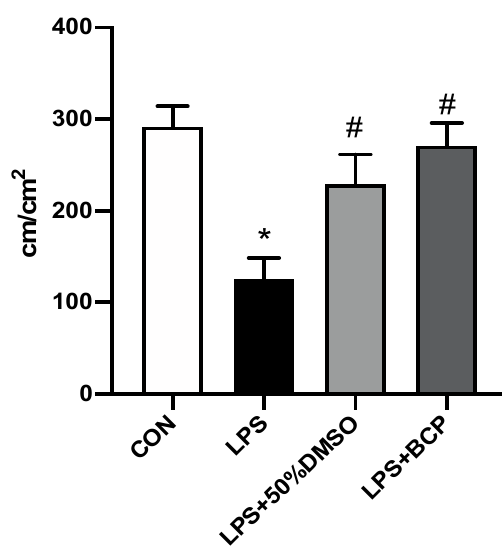
Figure 6. Capillary perfusion quantified through FCD within the bladder microcirculation of female BALB/c mice for the following experimental groups: control (CON; n = 6), LPS-induced IC (LPS; n = 5), LPS-induced IC treated with 50% DMSO, (LPS + 50% DMSO, n = 5), LPS-induced IC treated with BCP (100 mg/kg, LPS + BCP; n = 6). Saline, LPS, DMSO, and BCP were all administered via intravesical instillation. Data are presented as mean ± SD. * p < 0.05 vs. CON. # p < 0.05 vs. LPS.